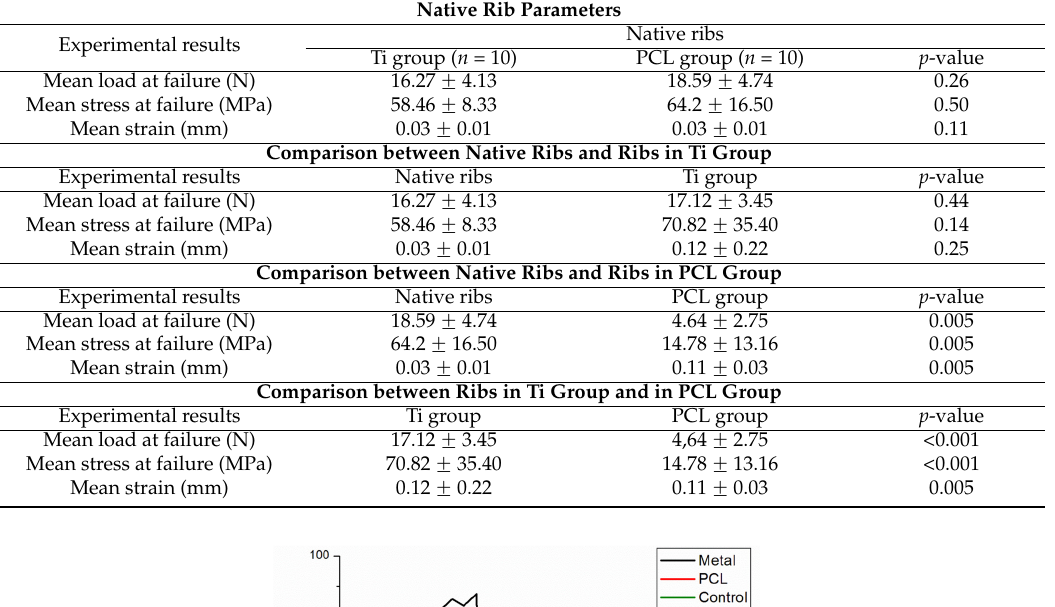
Table 1. The result of the three-point bending test of the native ribs, Ti group, and polycaprolactone (PCL) group.